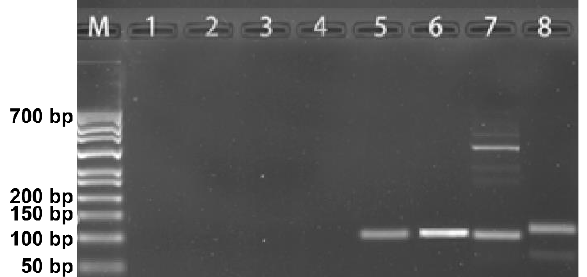
Figure 3. Detection of primers screening gel electrophoresis results. M: 700 bp DNA ladder; lane 1–4: blank; lane 5 – 8: the sample of the amplification of the CAI-A, CAI-B, CAI-C, CAI-D primers.